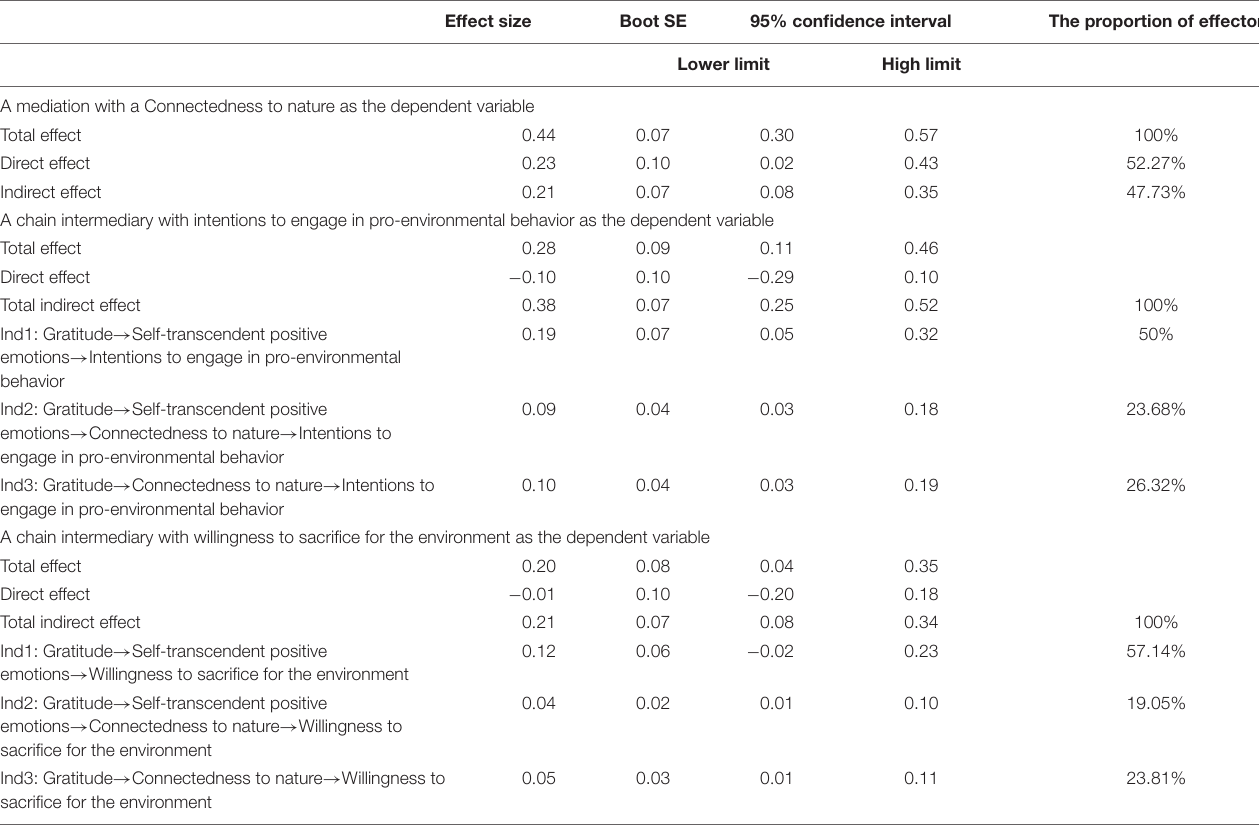
TABLE 3 | Mediating effects values and confidence intervals under the gratitude